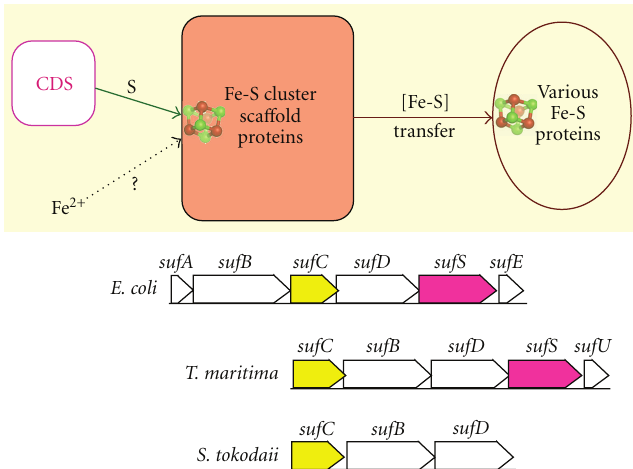
Figure 2: Schematic illustration of the cysteine desulfurase (CDS)-mediated, transient Fe-S cluster assembly on Fe-S cluster sca ff old proteins and subsequent cluster transfer to various target apoproteins [7, 99, 116] (top), and the organization of the suf gene clusters annotated in the E. coli , T. maritima , and S. tokodaii genomic sequences (bottom).